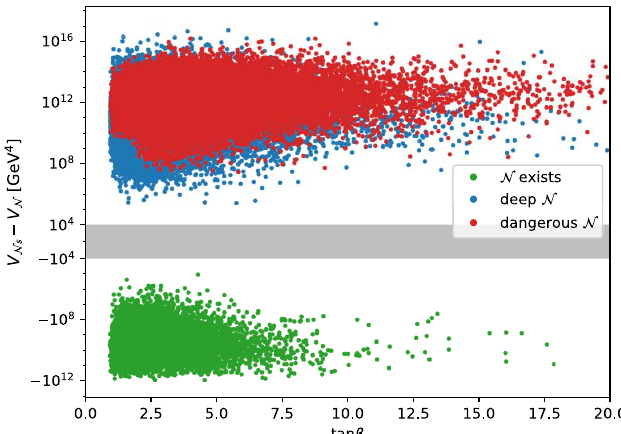
s vacuum and N minimum but N